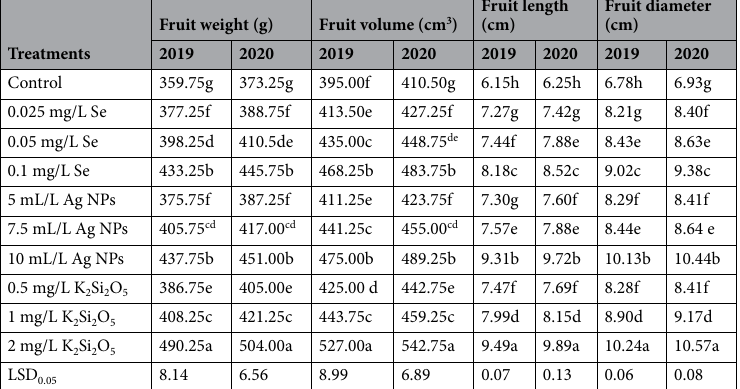
Table 5. Influence of the foliar spraying of Se, Ag NPS and K 2 Si 2 O 5 on weight, volume, length, and diameter of “Succary” pomegranate fruit during 2019 and 2020 seasons. Means not sharing the same letter(s) within each column are significantly different according to LSD at 0.05 level of